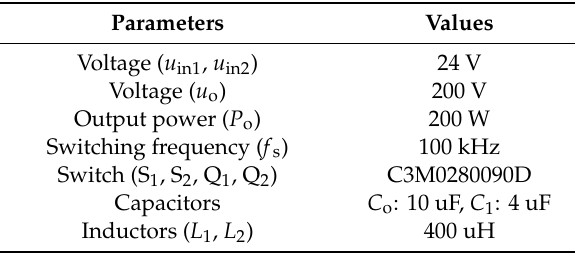
Table 2. Specification of the prototype.